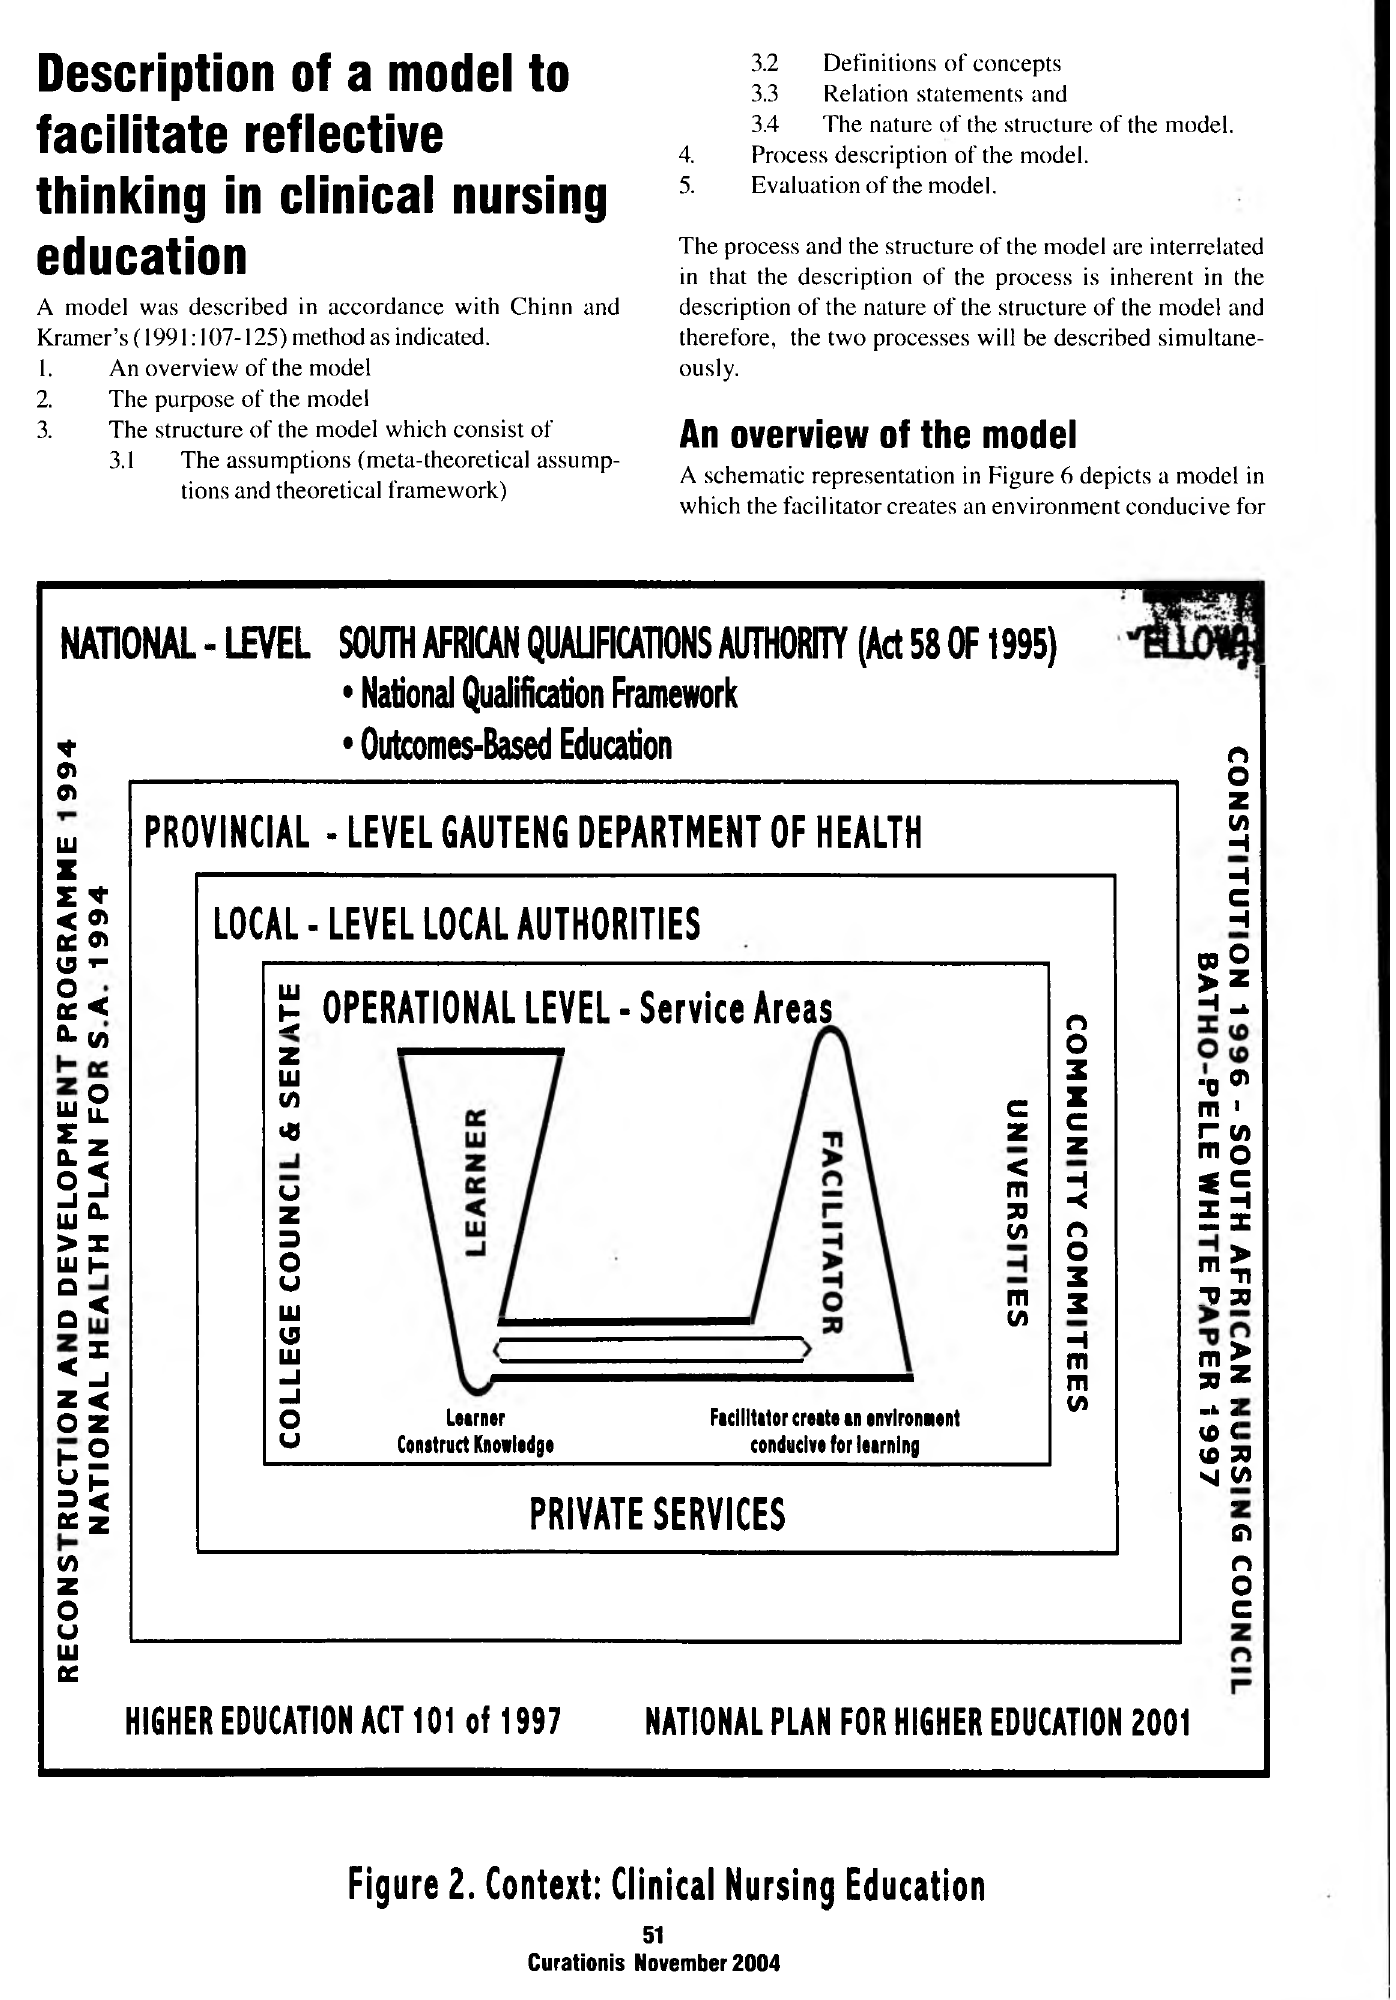
Figure 2. Context: Clinical Nursing